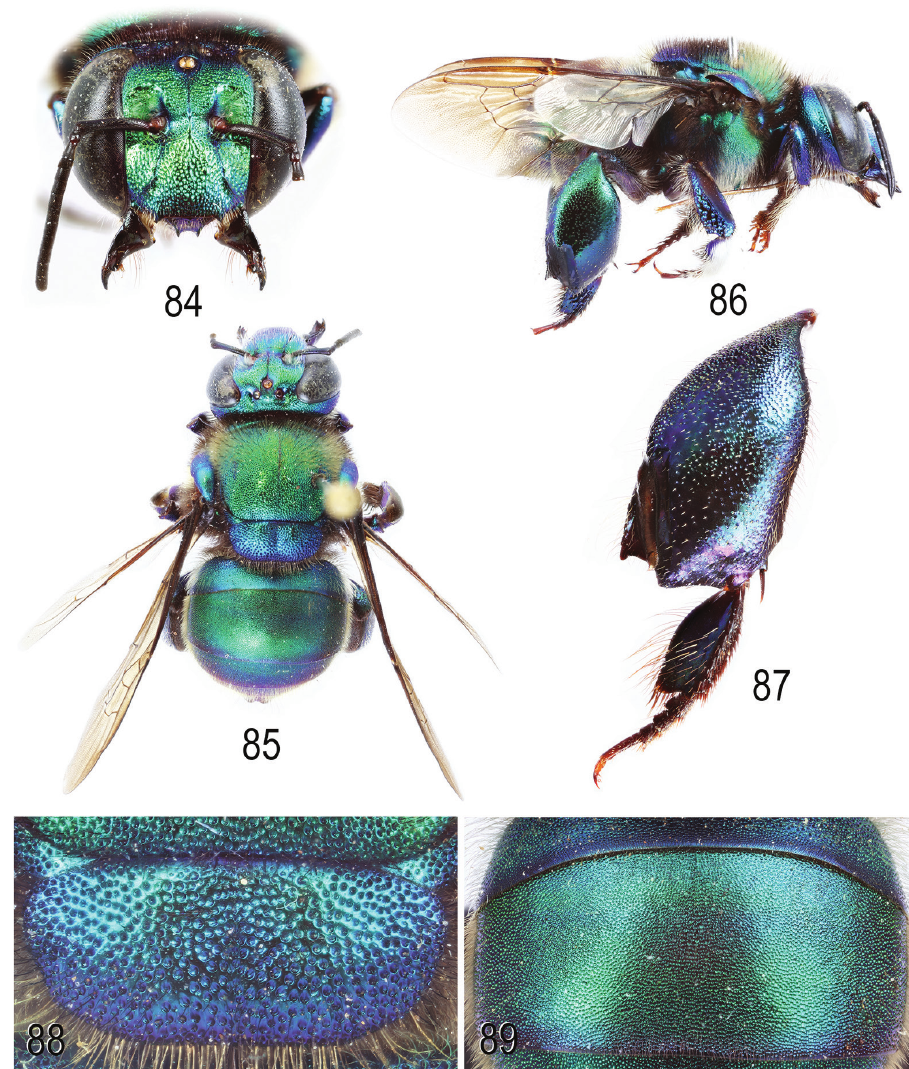
Figures 84–89. Male holotype of E. barthelli (except paratype in Fig. 87, KUNHM-ENT 0504535). 84 Facial view 85 Dorsal habitus 86 Lateral habitus 87 Outer view of hind leg 88 Dorsal view of mesos- cutellum 89 Second metasomal